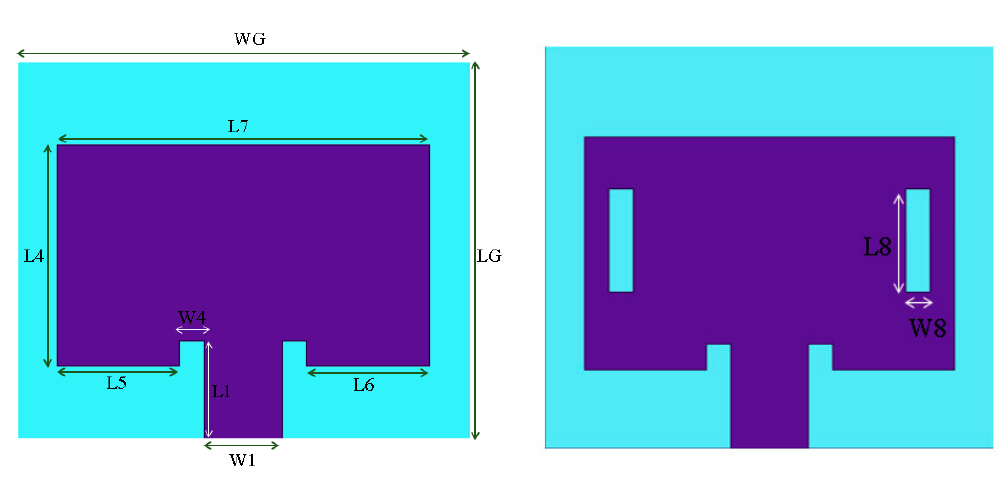
Figure 2. Full ground plane microstrip antenna without slots on the left side and with two slots on the right side being parallel to resonance edges fabricated on FR-4 substrate with a thickness of 1.6 mm. Table 1. The values of the proposed microstrip antenna with its parameters without slots. Parameter